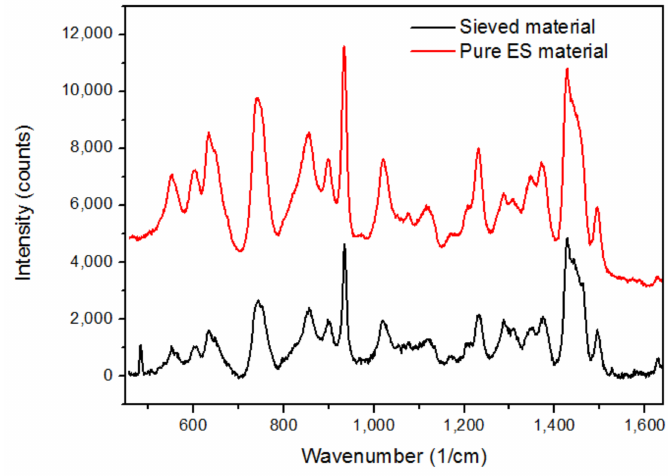
Figure 5. Raman spectra pure ES (red) and sieved (black)